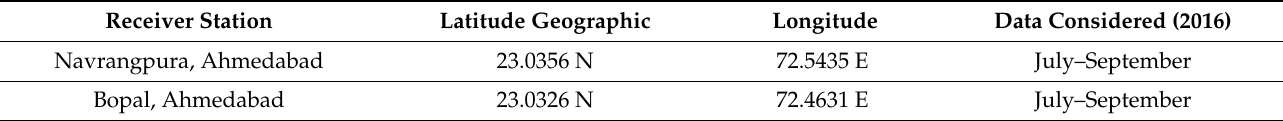
Table 2. Receiver locations in